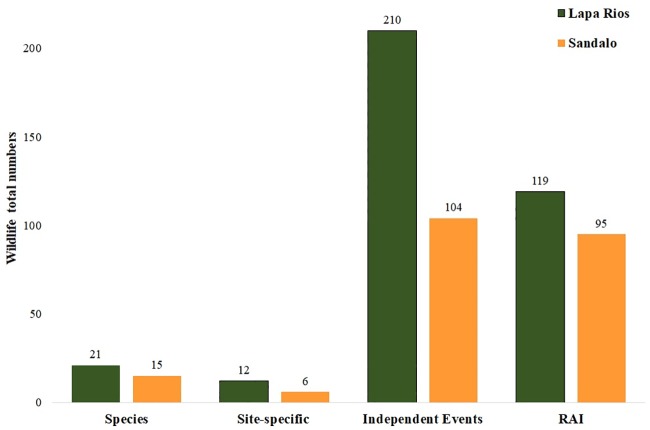
Total number of species, site-specific taxa, events, and RAI in Lapa Rios Ecolodge Nature Reserve and Playa Sandalo.Relative Abundance Index (RAI) = total events / trapping days *100. Domestic animals not included.